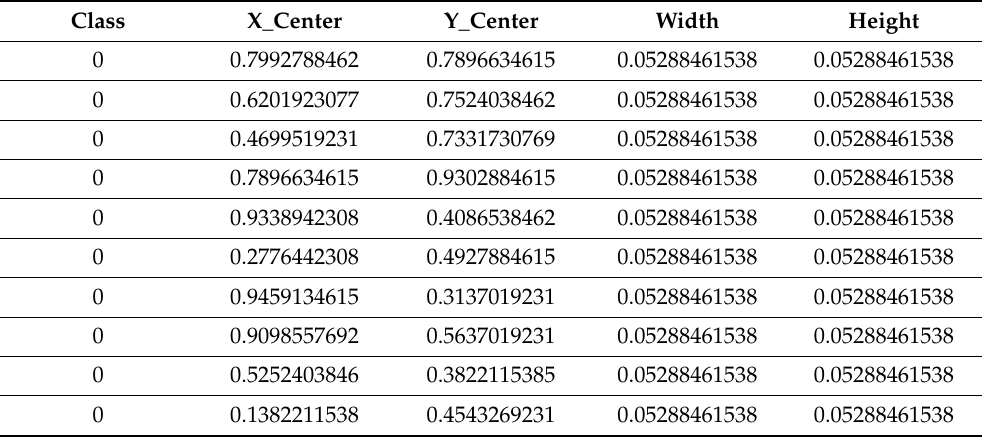
Table 2. Sample YOLOv5 annotation file contains the class, x_center, y_center, width, and height of the annotations.